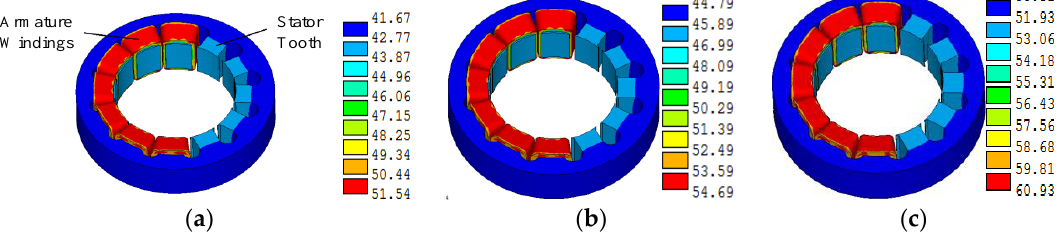
Figure 11. Schematic diagram of the stator components.